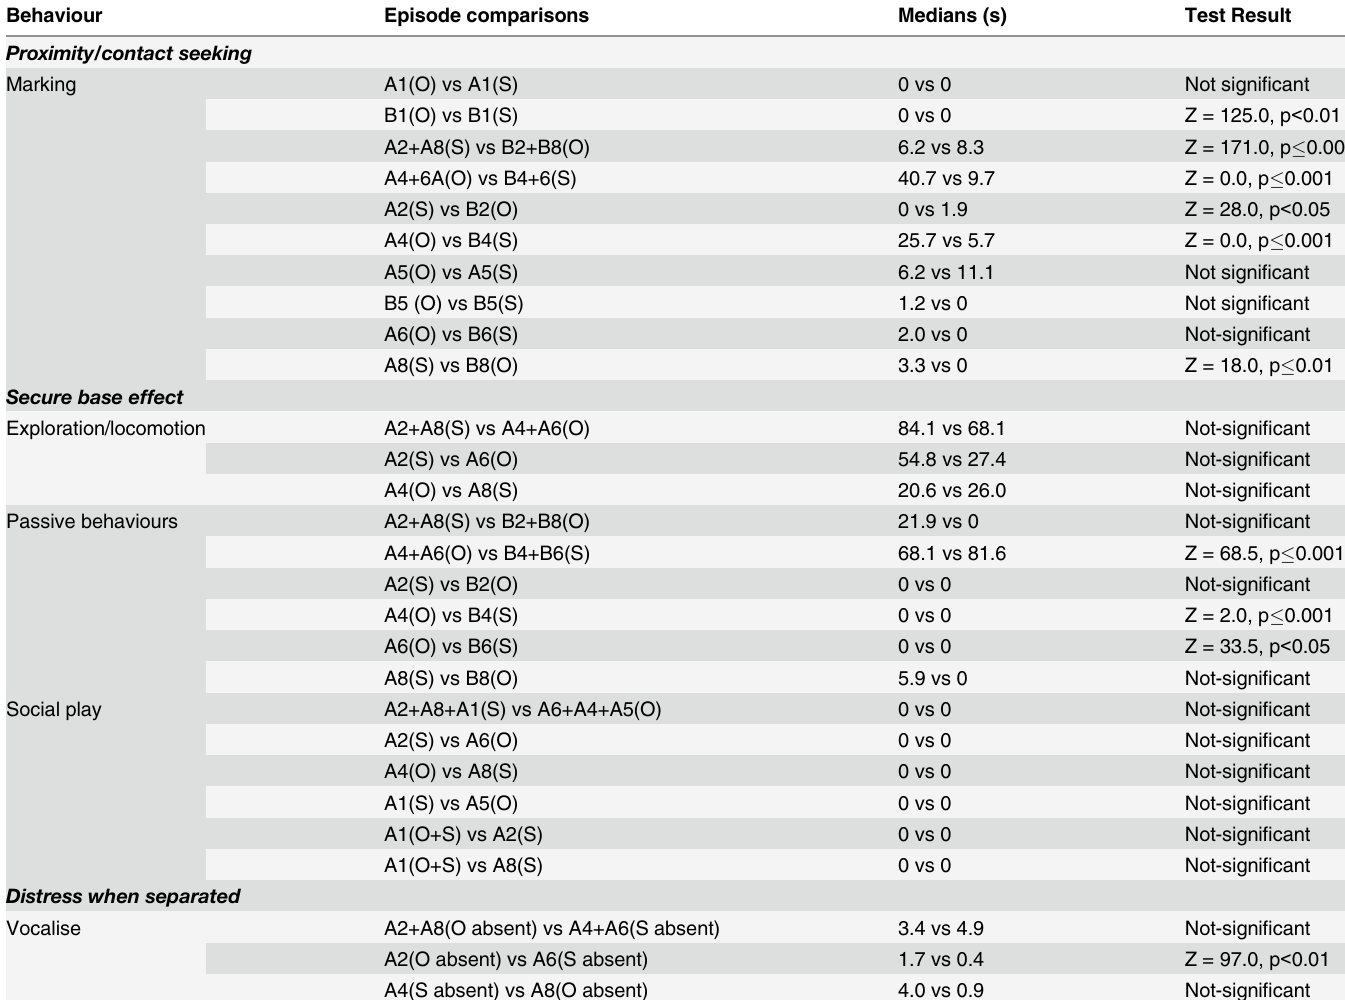
Table 3. Summary of attachment behaviour results from Wilcoxon signed ranks test. Key: O = owner present, S = stranger present, A1 – A8 = modified condition A episodes 1 – 8, B1 – B8 = reversed condition B episodes 1 – 8, Z = Wilcoxon signed ranks test